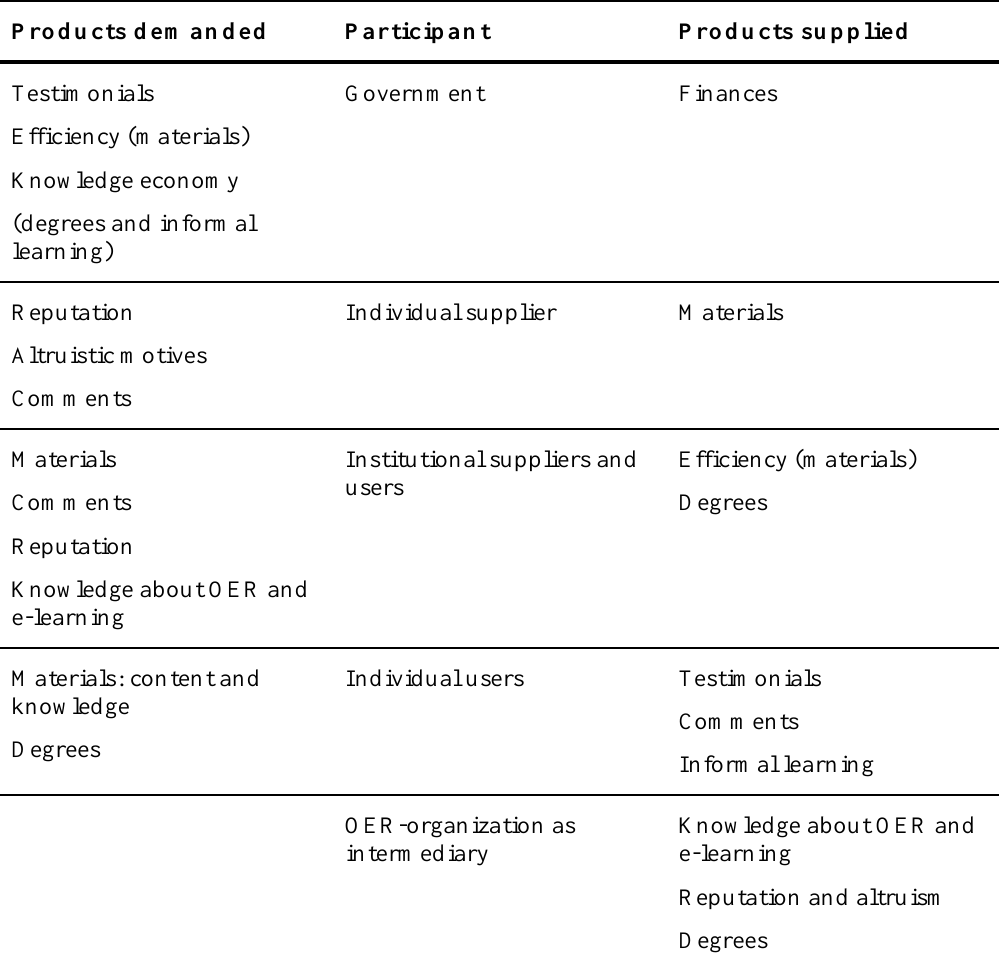
Products Supplied and Demanded by the Participants in the OER-System Products